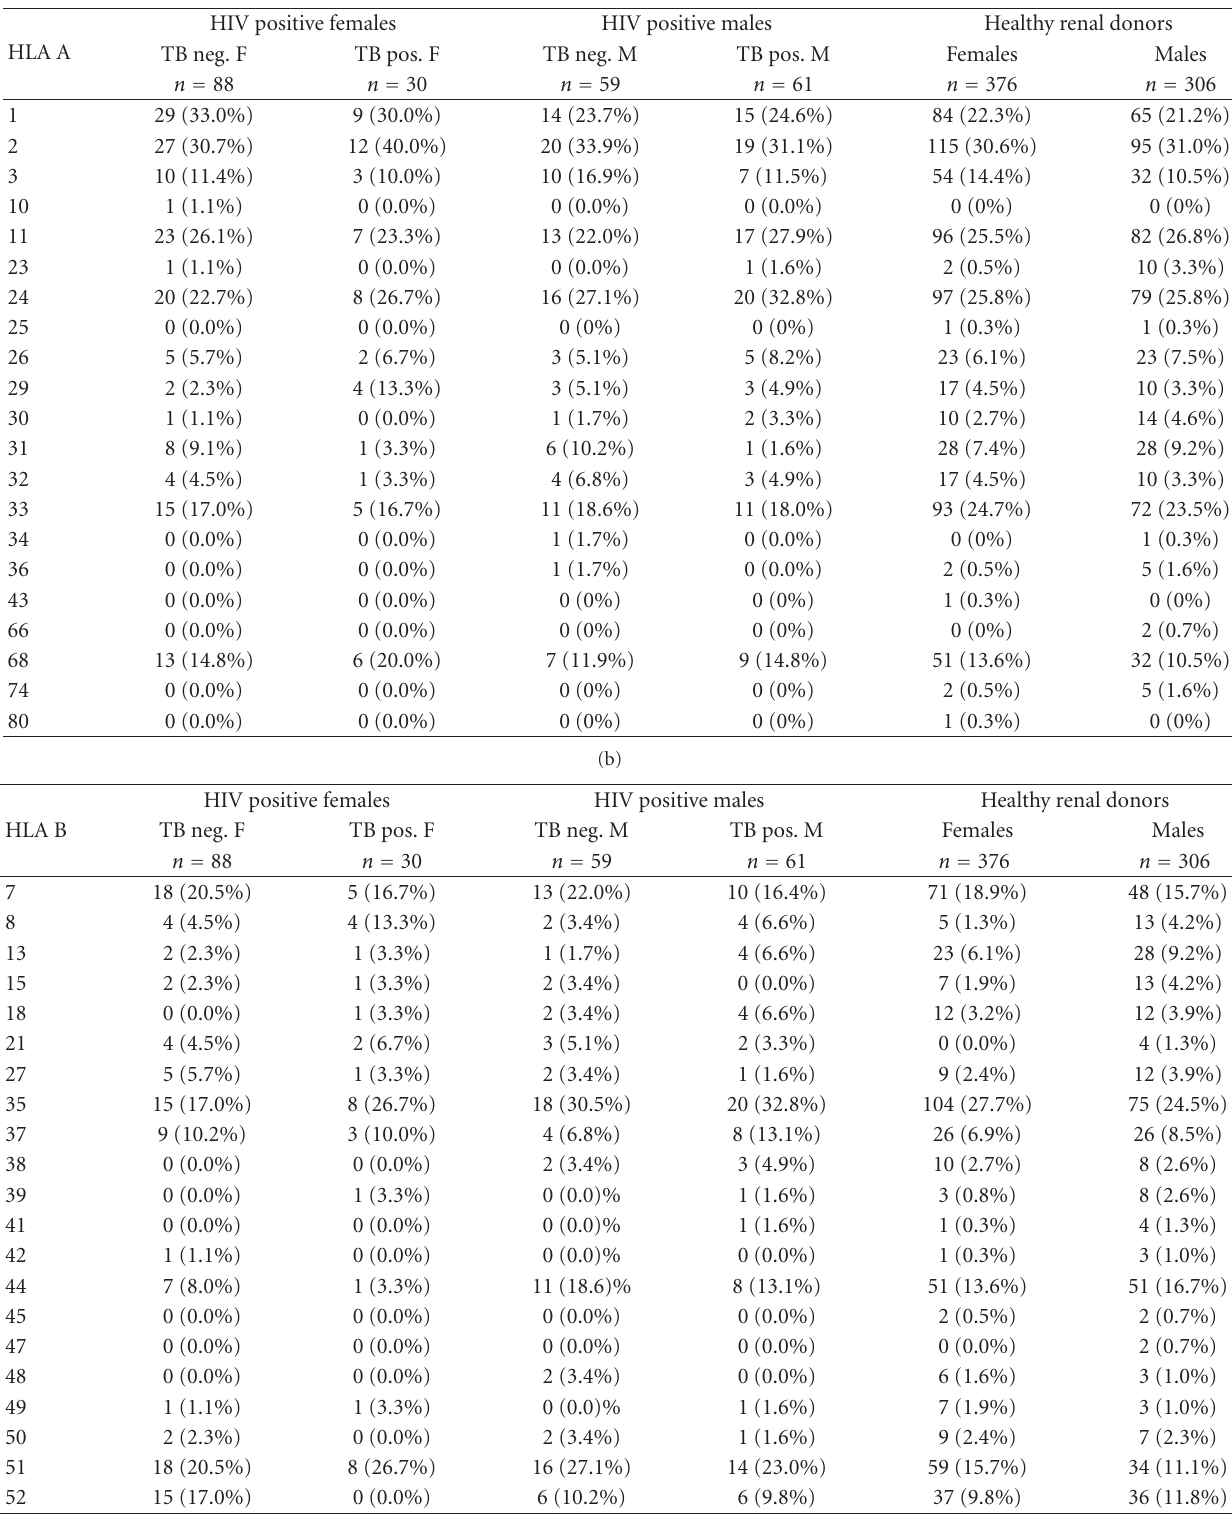
Table 2: (a) Frequency distribution of HLA A alleles among HIV positive subjects with and without TB and among healthy renal donors (control sample). (b) Frequency distribution of HLA B alleles among HIV positive subjects with and without TB and among healthy renal donors (control sample). (c) Frequency distribution of HLA DR alleles among HIV positive subjects with and without TB and among healthy renal donors (control